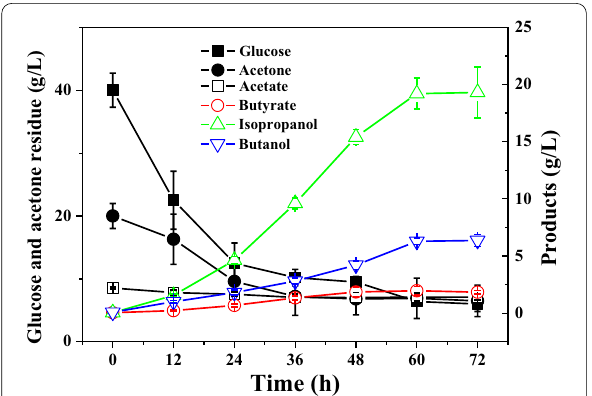
Fig. 6 BI fermentation by Clostridium beijerinckii XH29 in P2 medium supplemented with glucose and